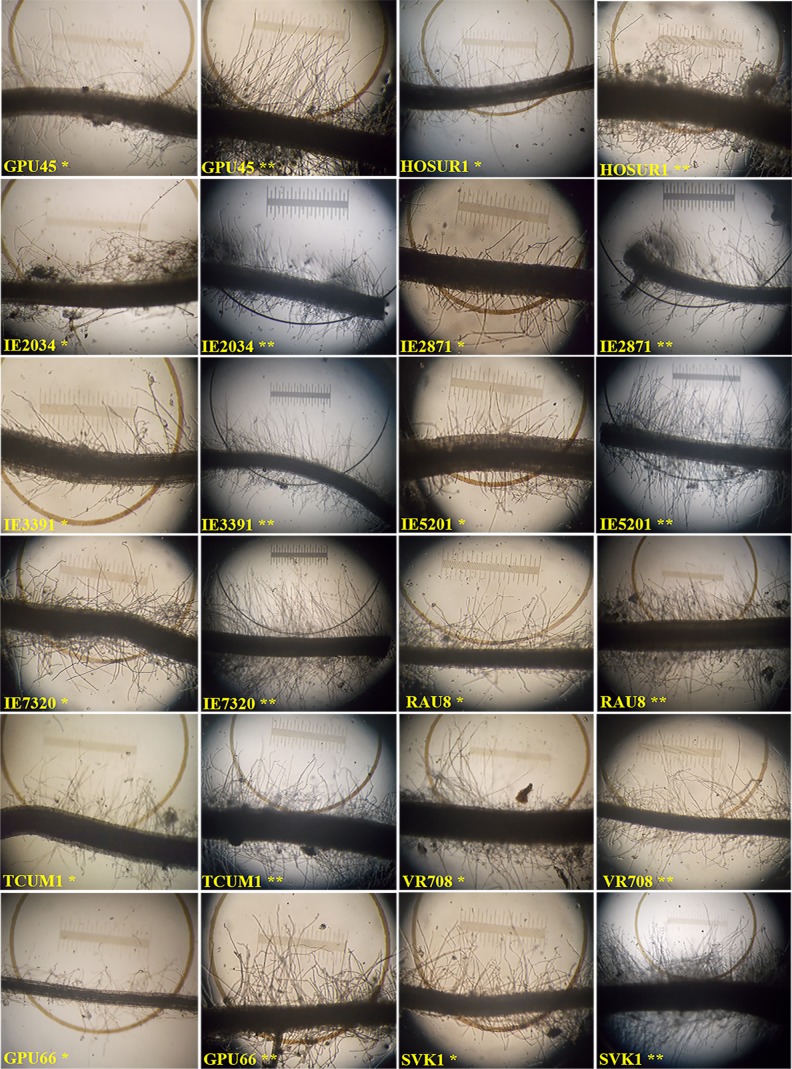
Root hair responses in the selected low P responding finger millet genotypes showing low and high number of root hairs under Psuf (*) and Pdef (**) conditions respectively.